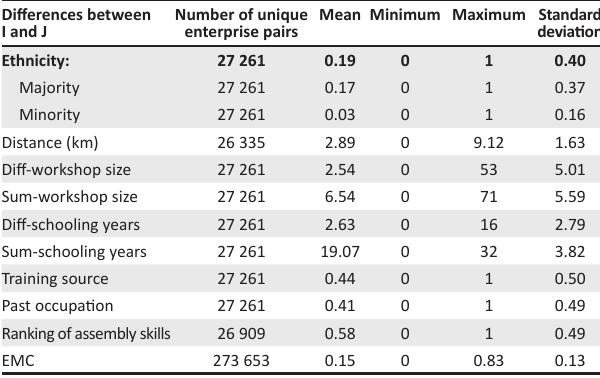
TABLE 2: Pair data statistics.